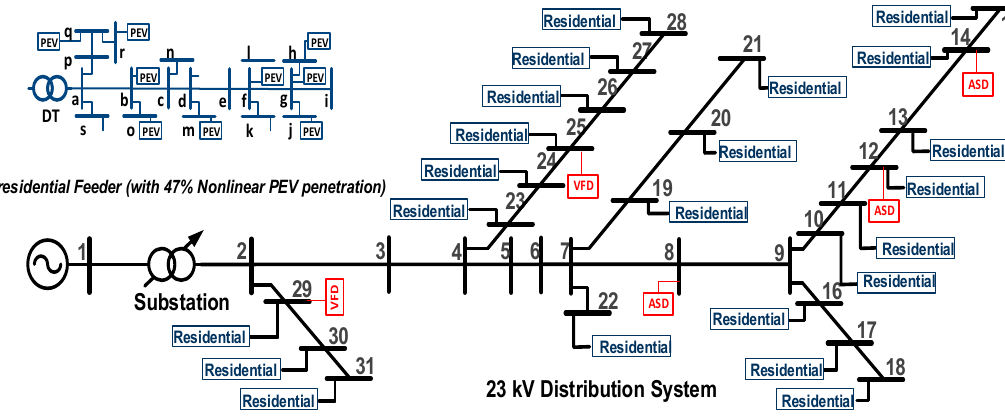
Figure 3. The 449-node smart grid system consisting of the IEEE 31 node 23 kV system with 22 low voltage 415 V residential feeders populated with 47% PEVs including nonlinear battery chargers and five nonlinear industry loads.